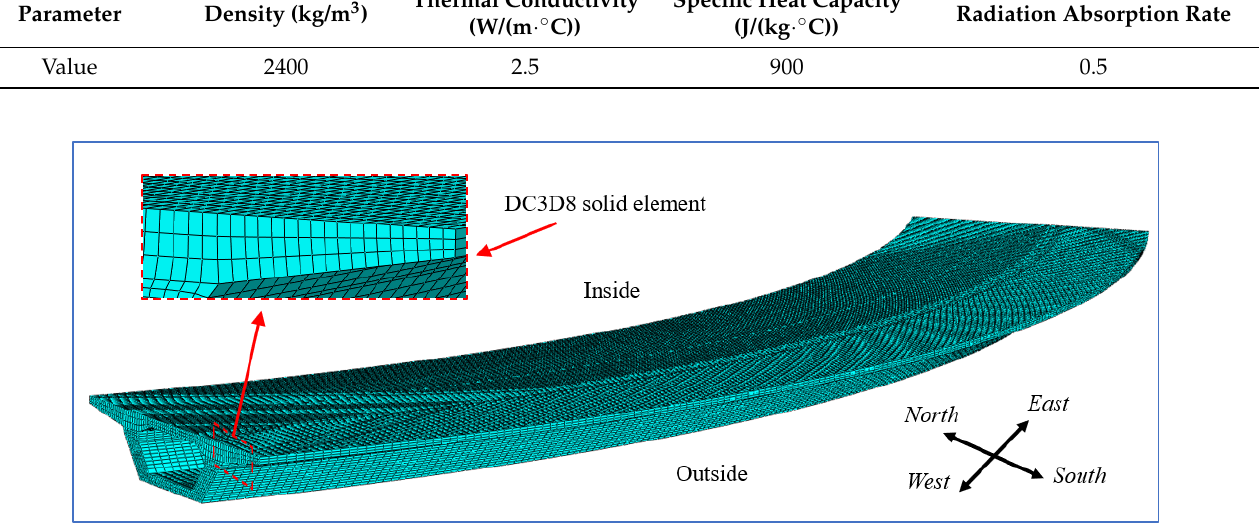
Figure 13. The finite element model and mesh division diagram.